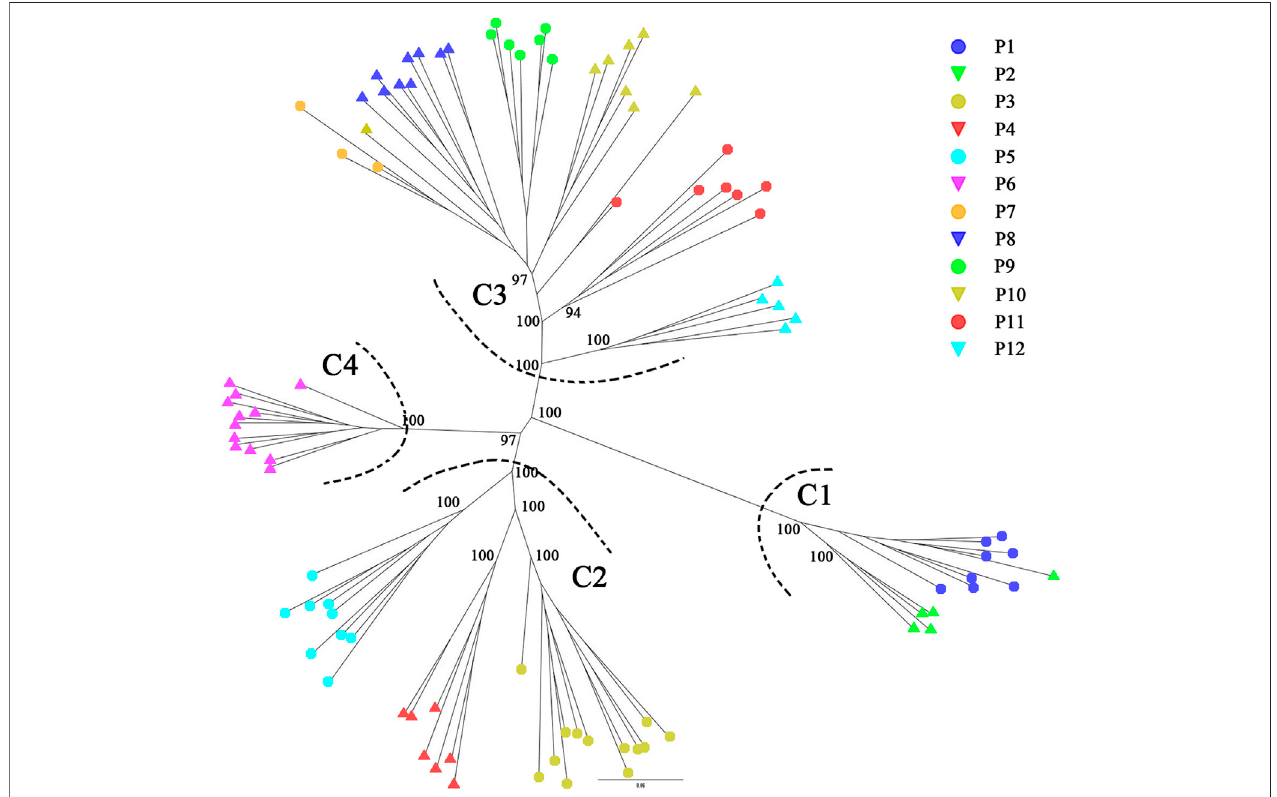
FIGURE 7 | STRUCTURE assignment results of the 94 individuals from 12 populations for K (cid:1) 3, K (cid:1) 4, and K (cid:1) 5. Different colors represent different gene pools. P1 – P12: population ID for the 12 populations of Primulina danxiaensis . C1 – C4: four clades assigned in phylogenetic tree.